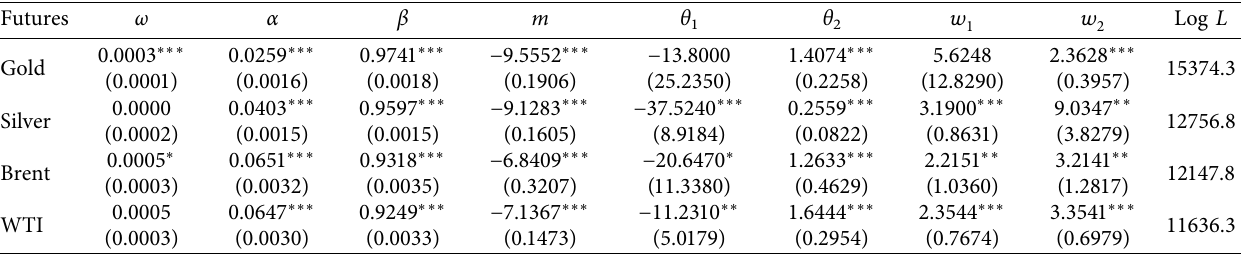
Table 8: Estimation results of GARCH-MIDAS +RV +ID-EMV models of futures volatility by infectious disease with 9-month lags. Futures